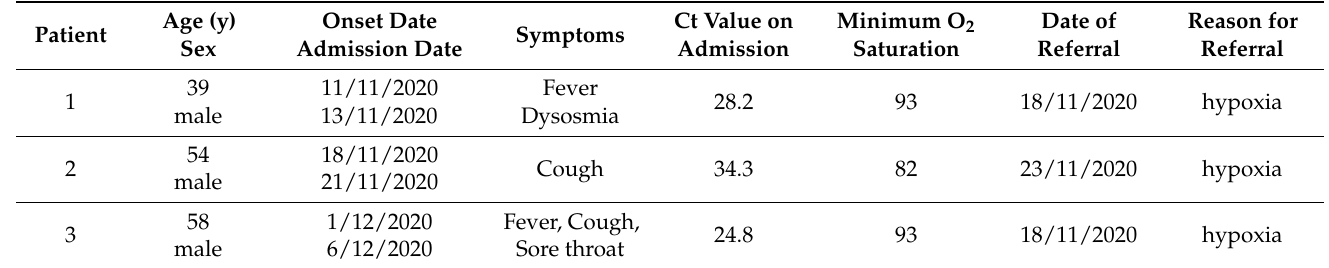
Table 2. Characteristics of patients referred to the hospital.